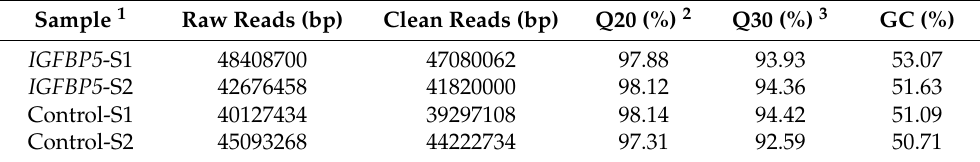
Figure 5. The relative abundance of IGFBP5 mRNA in goose fatty liver versus normal liver. Note: The relative abundance of IGFBP5 mRNA was determined in goose fatty liver and normal liver by quantitative PCR and is presented as fold change over control. N = 6. ** denotes p < 0.01 vs. control. The data are expressed as the mean ± SE. Table 4. General information on sequencing data.